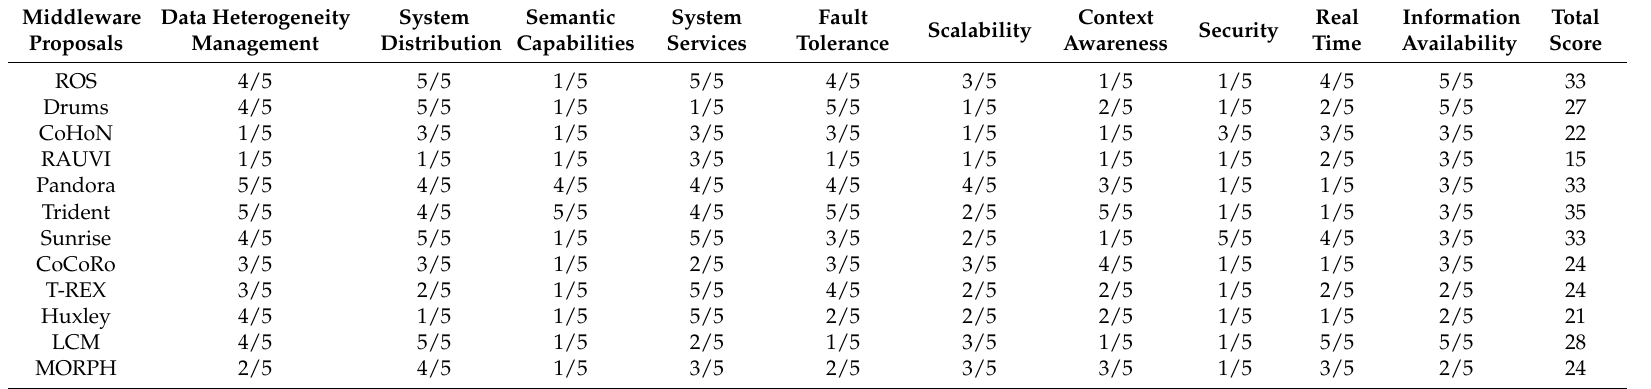
Table 23. Comparison of reviewed middleware